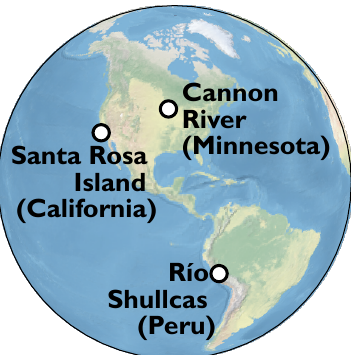
Figure 5. Our test sites include the high Andes, a mountainous is- land, and a formerly glaciated Mississippi